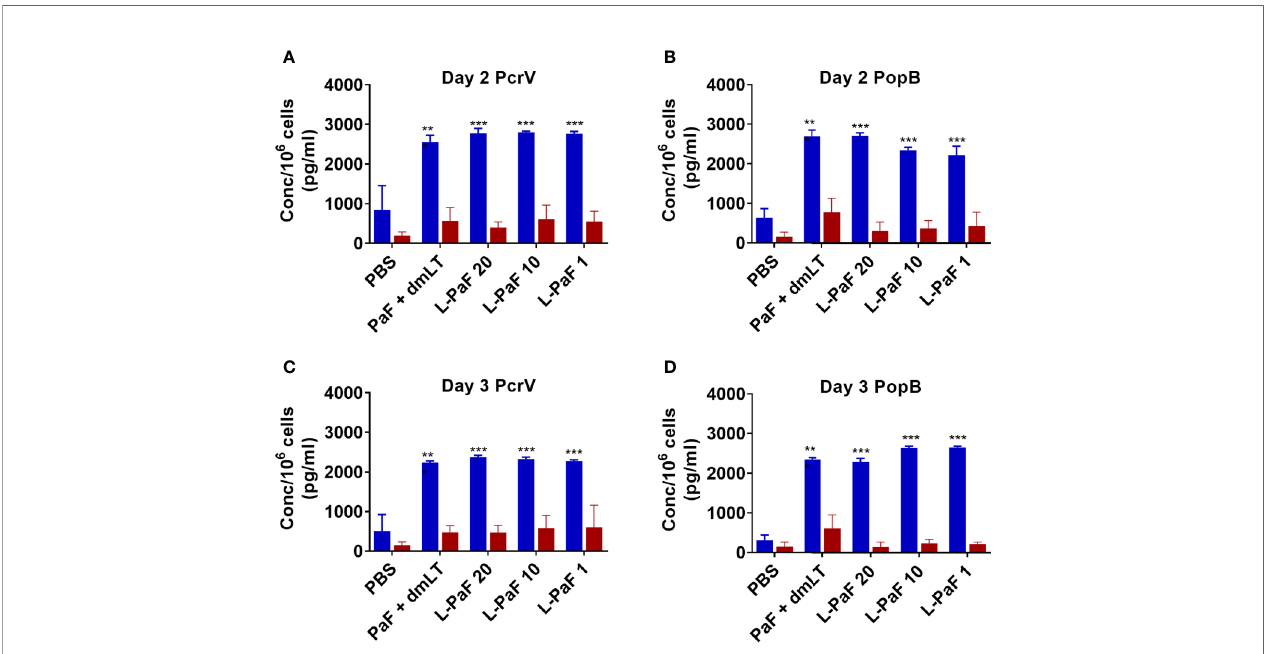
FIGURE 12 | Levels of IL-17 and IFN- g secreted from lung cells after stimulation with PcrV or PopB. The single lung cell suspensions from Figure 7 were used to assess antigen speci fi c IL-17 and IFN- g secretion from lung cell suspensions. Cells were incubated with 10 µg PcrV (top) or PopB (bottom). IL-17 (blue bars) and IFN- g (red bars) levels were determined by MesoScale Discovery analysis as per manufacturer ’ s speci fi cations and are presented here as pg/ml/10 6 cells. The data are plotted as means ± SD for individual mice in each group. Signi fi cance was calculated by comparing groups that were unvaccinated (PBS) and mice vaccinated with antigens using two-way ANOVA. **p < 0.01; ***p < 0.001.